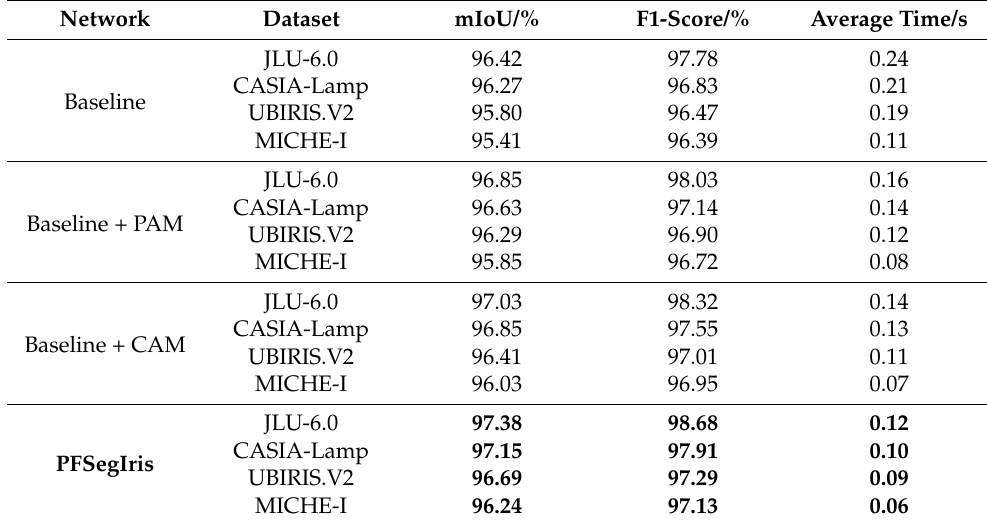
Table 7. The evaluation indexes of different networks on four iris datasets. Network